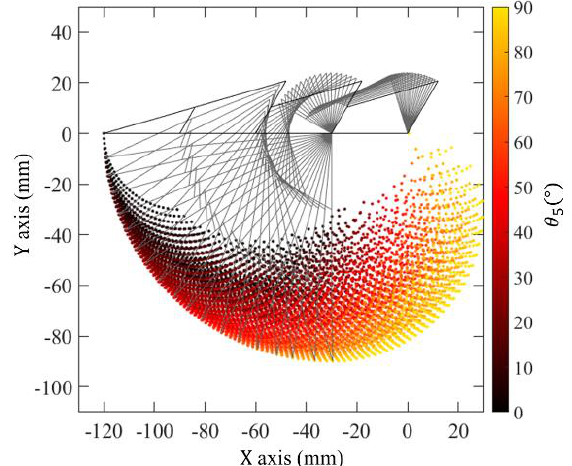
Figure 15. Scatter plot of the gripper’s range of motion.